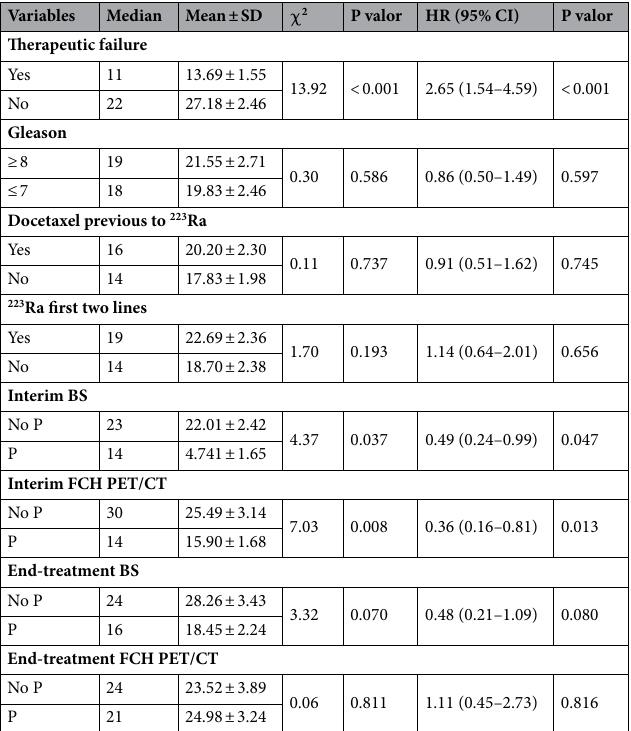
Table 5. Long rank tests and Cox regression results of association of clinical and imaging response variables with OS. HR hazard ratio, PFS progression free survival, χ 2 Chi-squared, P progression, no P no progression,